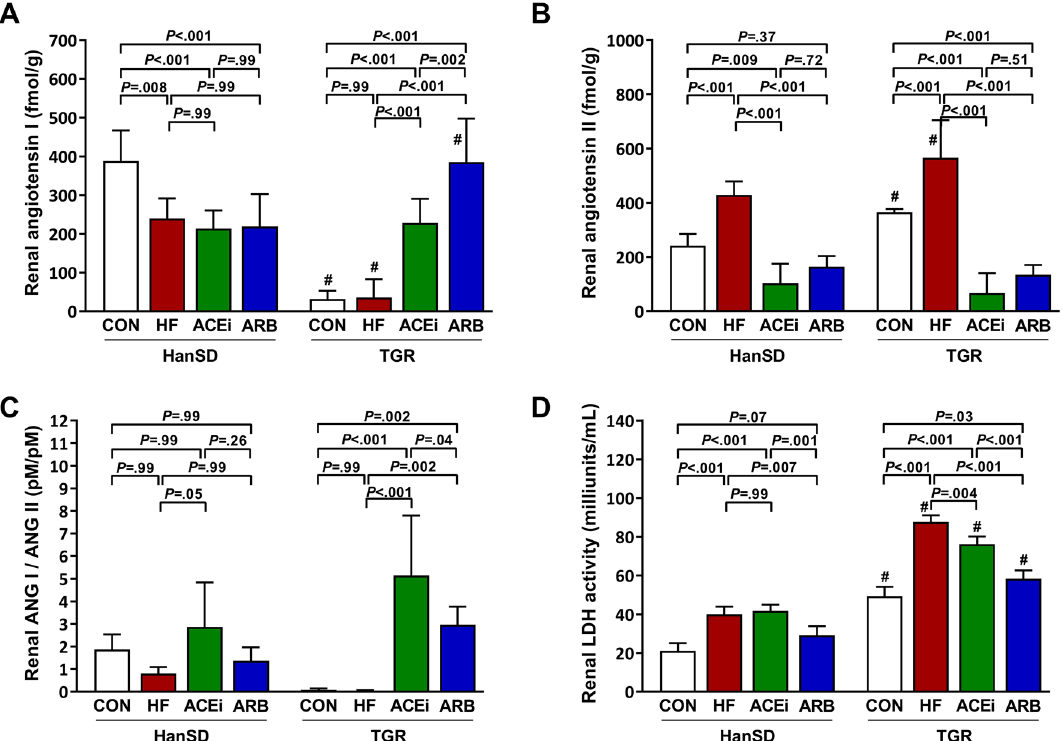
Figure 6. Renal angiotensin I levels ( A ), renal angiotensin II levels ( B ), renal angiotensin I to angiotensin II ratios ( C ) and renal lactate dehydrogenase (LDH) activity ( D ) of control (CON), untreated heart failure (HF), ACE inhibitor-treated (ACEi) and AT 1 receptor blocker-treated (ARB) HanSD and TGR rats 20 weeks after sham or ACF operation (5 weeks in HF TGR rats due to high mortality). Data presented as mean ± SD (n = 4–6 in each group). # P < 0.05 compared to HanSD